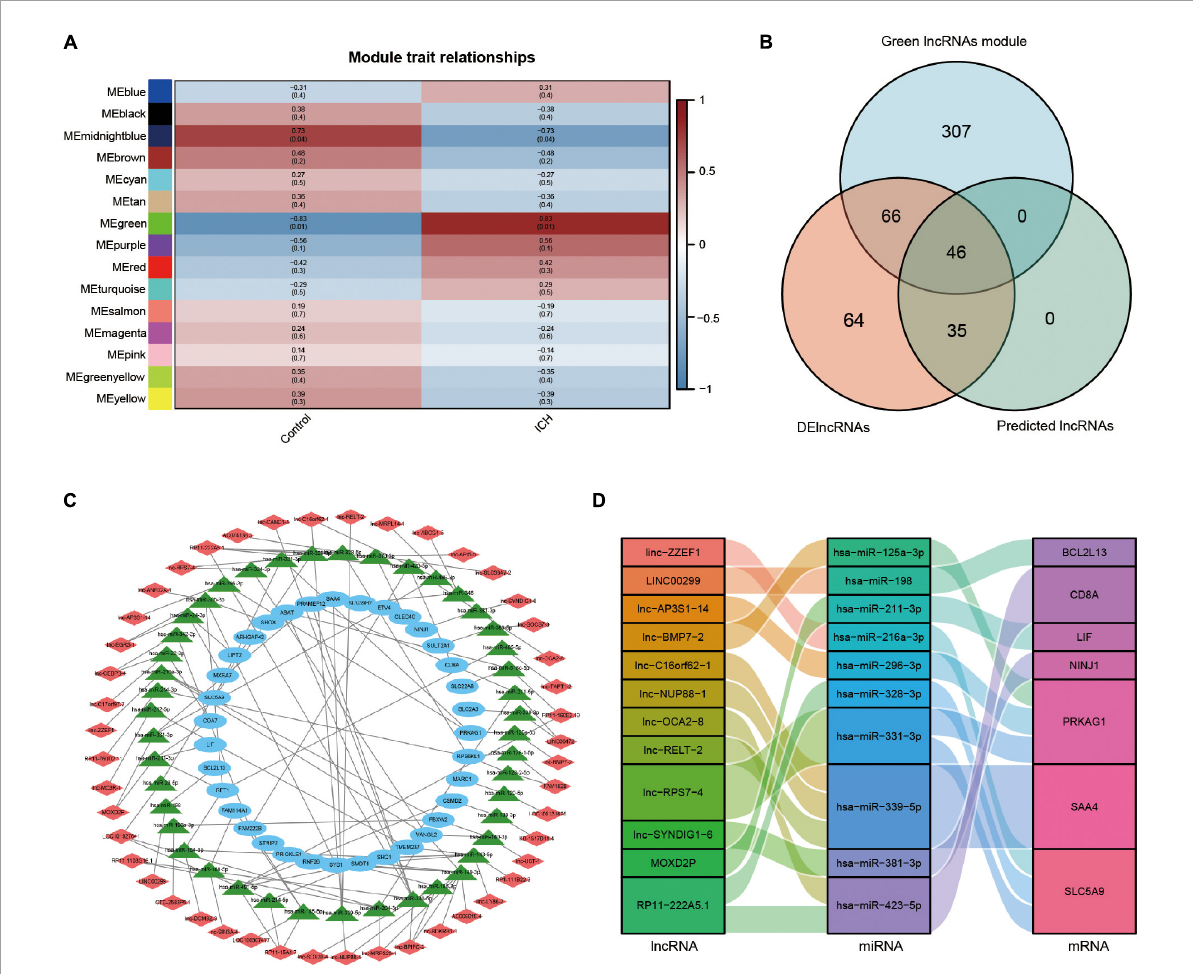
FIGURE7 Analysis of lncRNAs modules using WGCNA and the construction of lncRNAs associated ceRNA network in ICH. (A) Module trait relationships between ICH patients and control subjects. Red represented positive correlation, blue represented negative correlation, and darker colors represented higher correlation. (B) The venn diagram showed the intersection of the green lncRNAs module by WGCNA, the DElncRNAs from our microarray, and the predicted lncRNAs. (C) The constructed ceRNA network of lncRNAs from the intersection, the predicted miRNAs, and the DEmRNAs from our microarray was visualized by Cytoscape. Red diamond represented lncRNAs, green triangle represented miRNAs, and blue ellipse represented mRNAs. (D) The Sankey diagram showed the immune-related lncRNA-miRNA-mRNA ceRNA network in